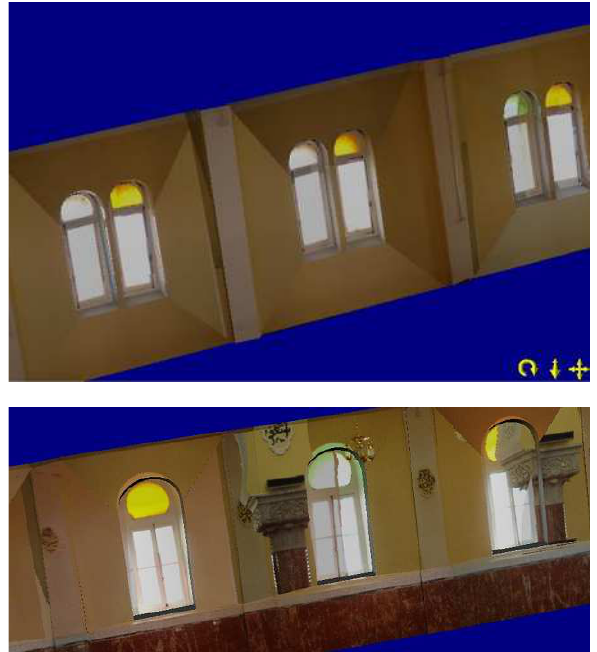
Figure 13. The misplaced texture and the lightening problem.